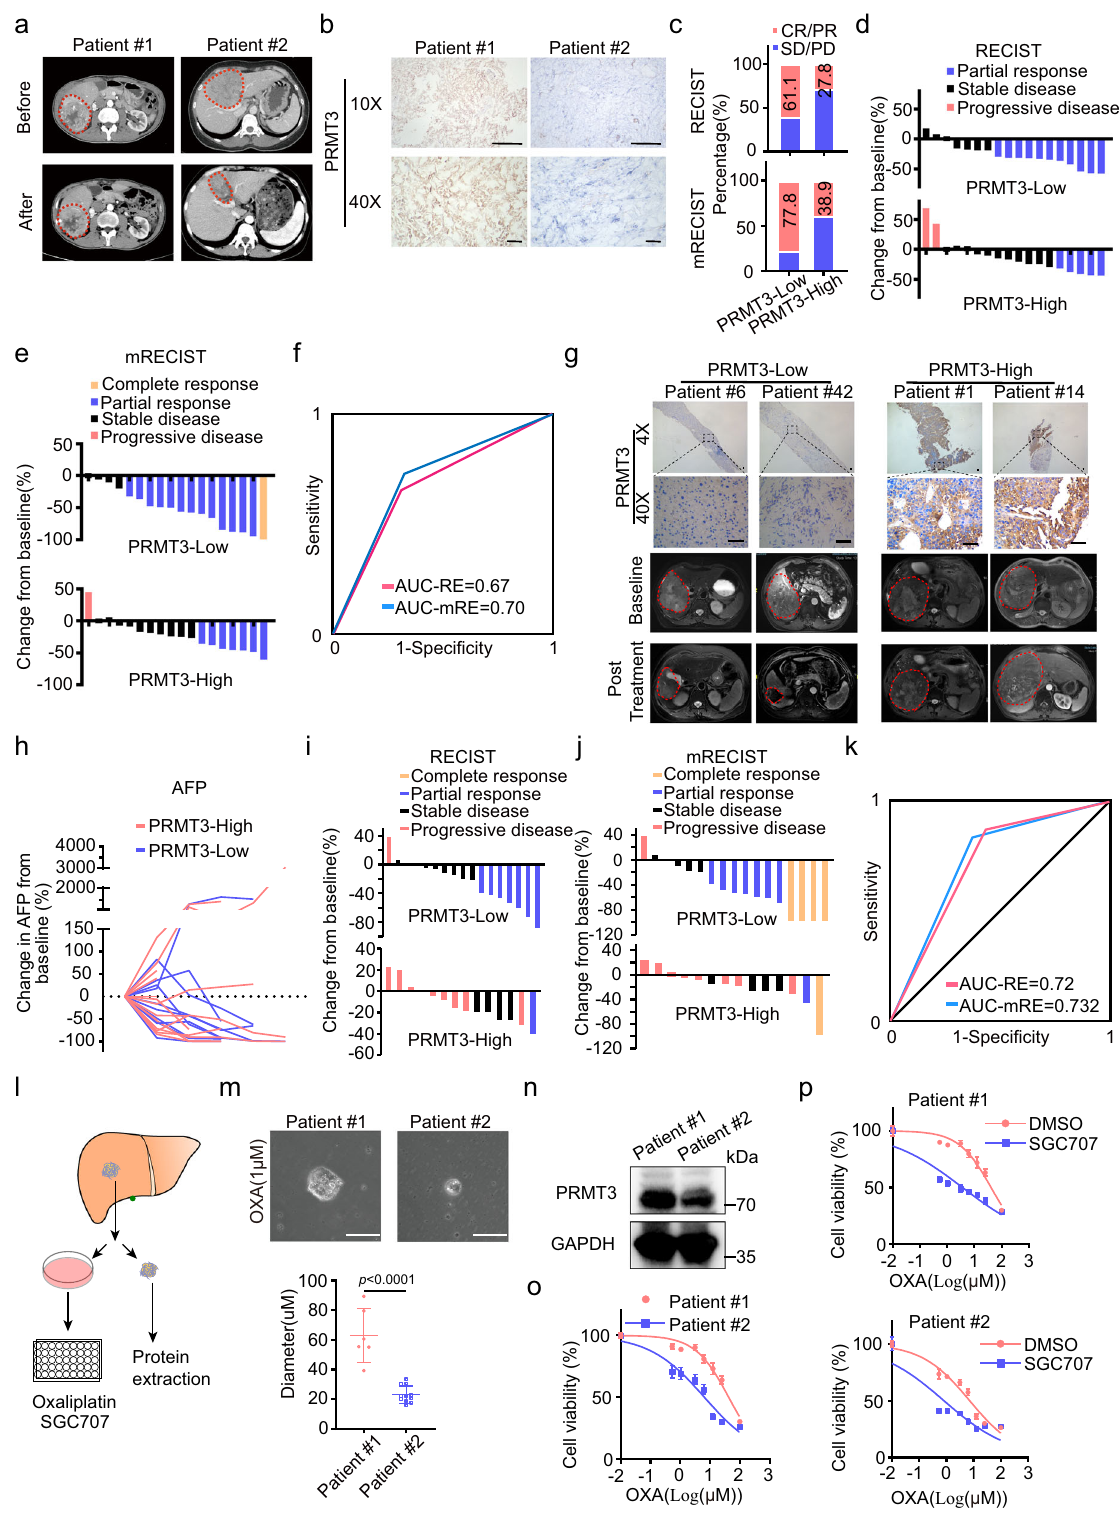
the indicated antibodies (anti-PRMT3 antibody, Abcam, Ab191562, 1:50 dilution; anti-IGF2BP1 antibody, Proteintech, 22803-1-Ap, 4 μ g; anti-FLAG antibody, Cell Signaling Technology, #14793, 4 μ g; Rabbit IgG, Proteintech, B900610, 2 μ g) overnight at 4 °C. Then, immune complexes were washed three times in cold lysis buffer. The input and output samples were resolved by SDS-PAGE and detected by immunoblot analysis with the indicated primary antibodies: anti-